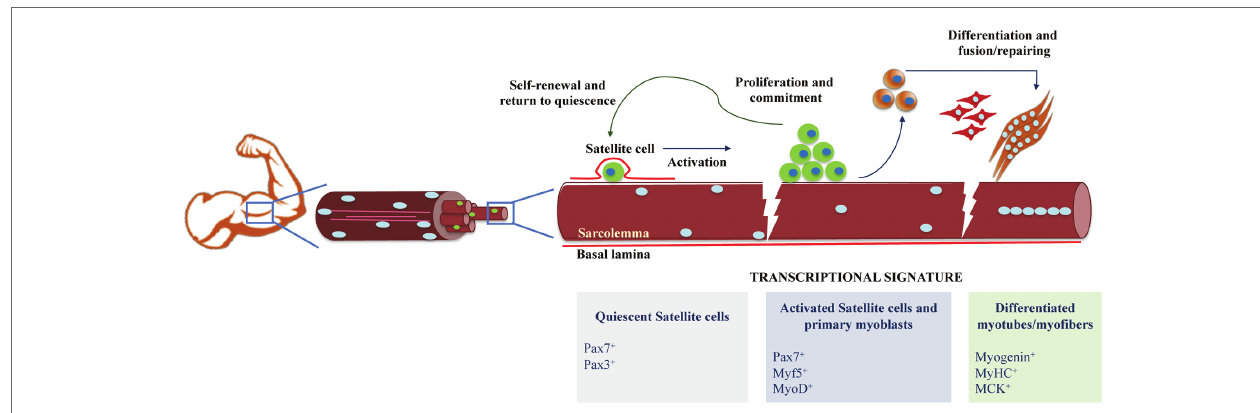
FIGURE 1 | Schematic representation of skeletal muscle differentiation. Muscle regeneration is possible thanks to the functionality of adult muscle stem cells and the satellite cells. In homeostatic conditions, satellite cells are in a quiescent state, and after different stimulus caused by damage, they proliferate to generate myogenic precursors and to repopulate the satellite cell niche. Myoblasts express markers of muscle identity and fuse to each other to generate myotubes and myofibers, to eventually repair the damaged muscle